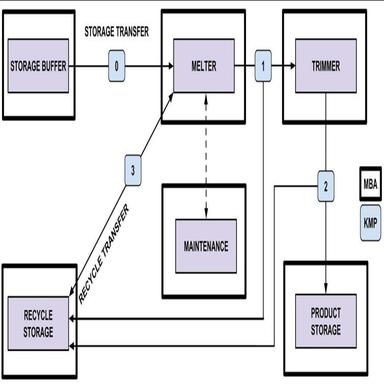
Baseline Design. An MBA is installed for each sub-process, and a KMP is located right after every process. Only weight measurement is performed at KMPs, and ID can be calculated by subtracting the measured batch weight at the previous KMP by the measured batch weight at a current KMP. The solid arrows represent material flows while the dashed arrow is for handling material in the planning phase. Now, no material is moved to the MBA installed around maintenance. If the melter fails, both the batch and the